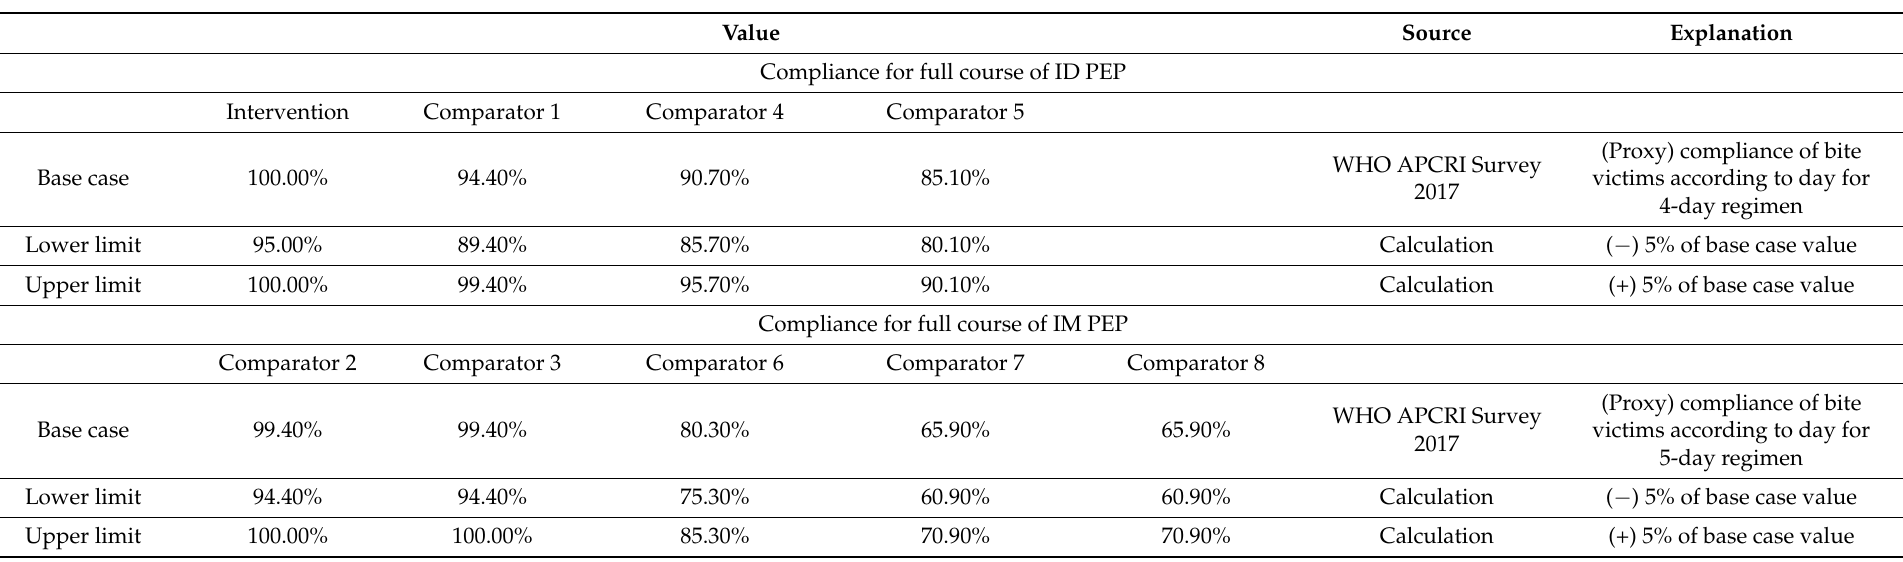
Table A2. Data inputs for one-way sensitivity and scenario analysis (children in age group 5–15 years)